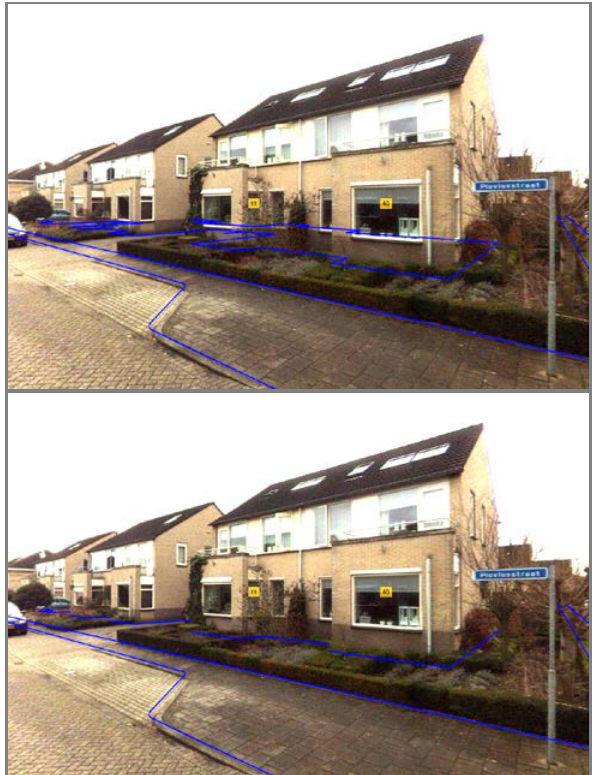
Figure 12. Hidden line removal from 2D base map